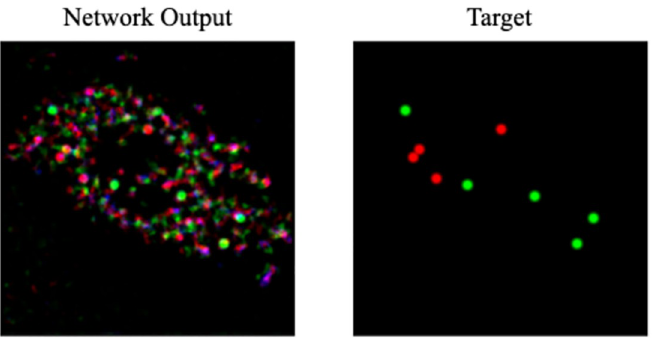
Fig 3. The output of the generator network using the ELP-MAE loss. The output image can be compared to the target image to see the accuracy of the network output. A negative by-product of the penalty factor that is used in the ELP-MAE loss function are random noise